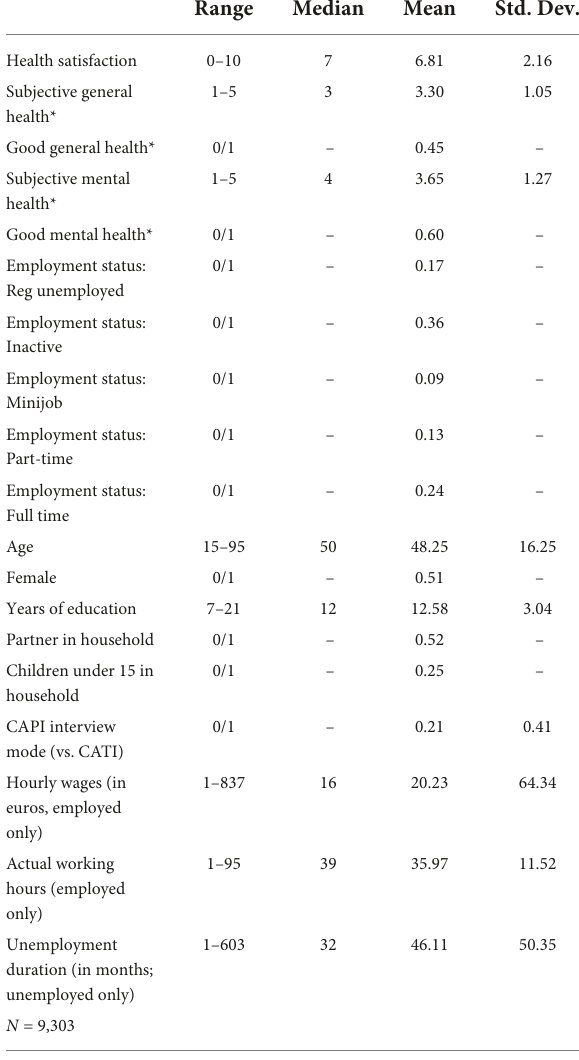
TABLE 2 Sample descriptive